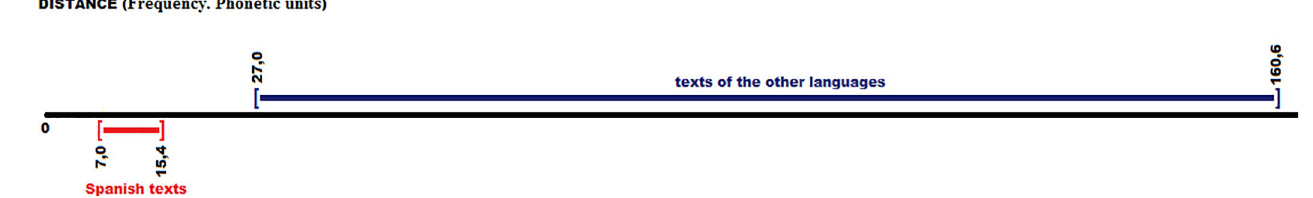
Fig 12. Distances between the Spanish or Castilian (average value) with all the texts of all the languages (phonetic units).